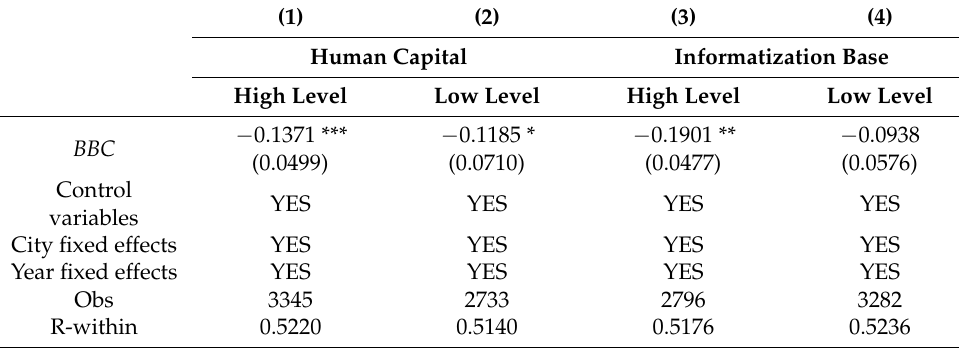
Table 9. Human capital and informatization base.